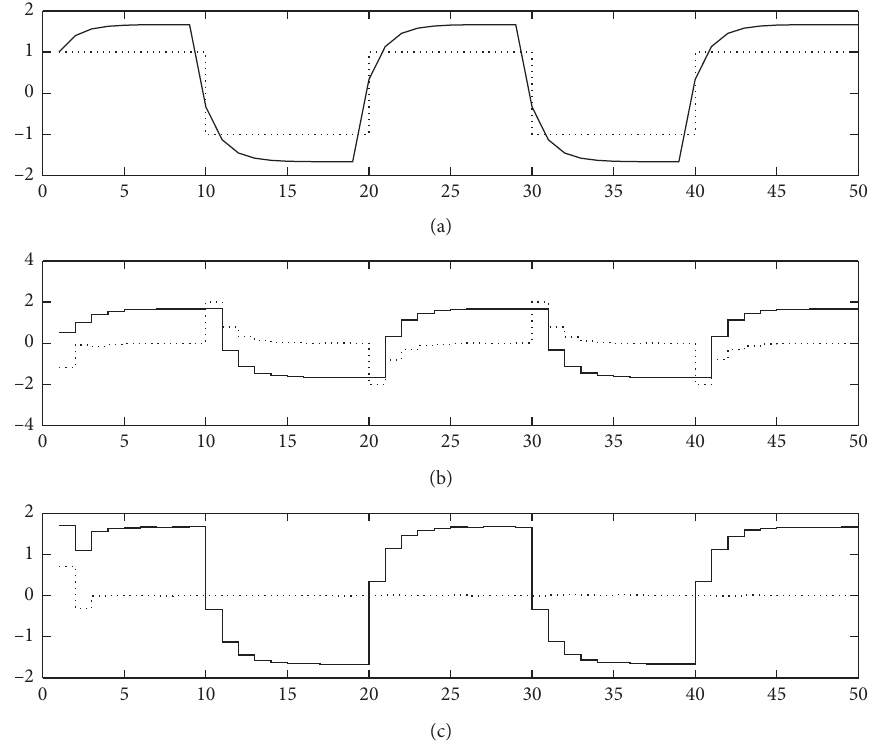
Figure 3: Tracking control of discrete-time chaotic system with trajectories (a) x